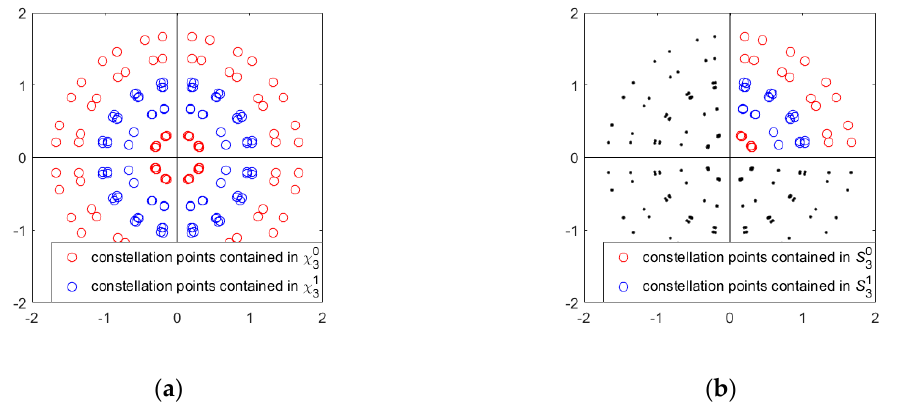
Figure 3. The subsets of ED comparison to calculate LLR( 𝑏 (cid:2874) ) when the received symbol is in the first quadrant. ( a ) Subsets of Max-Log-MAP algorithm; ( b ) Subsets obtained after some constellation points are removed.